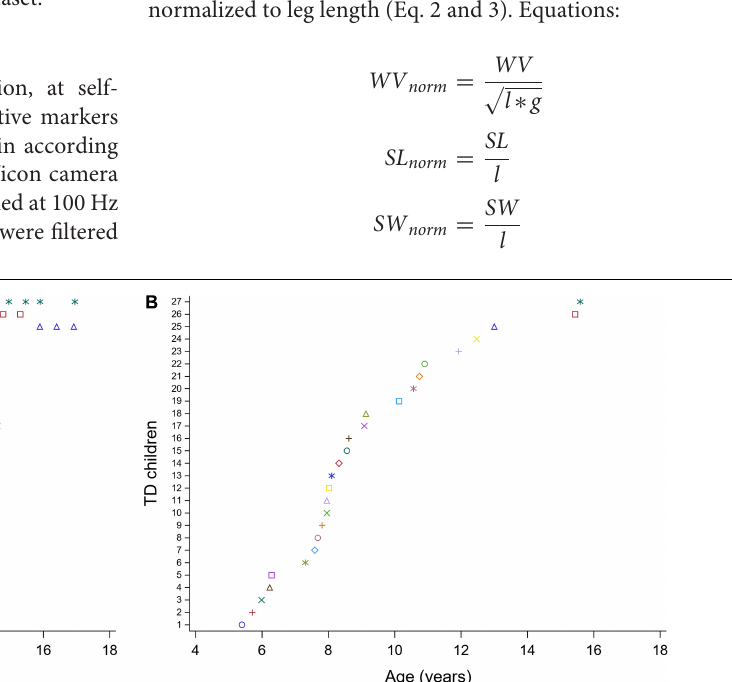
Frontiers in Human Neuroscience |